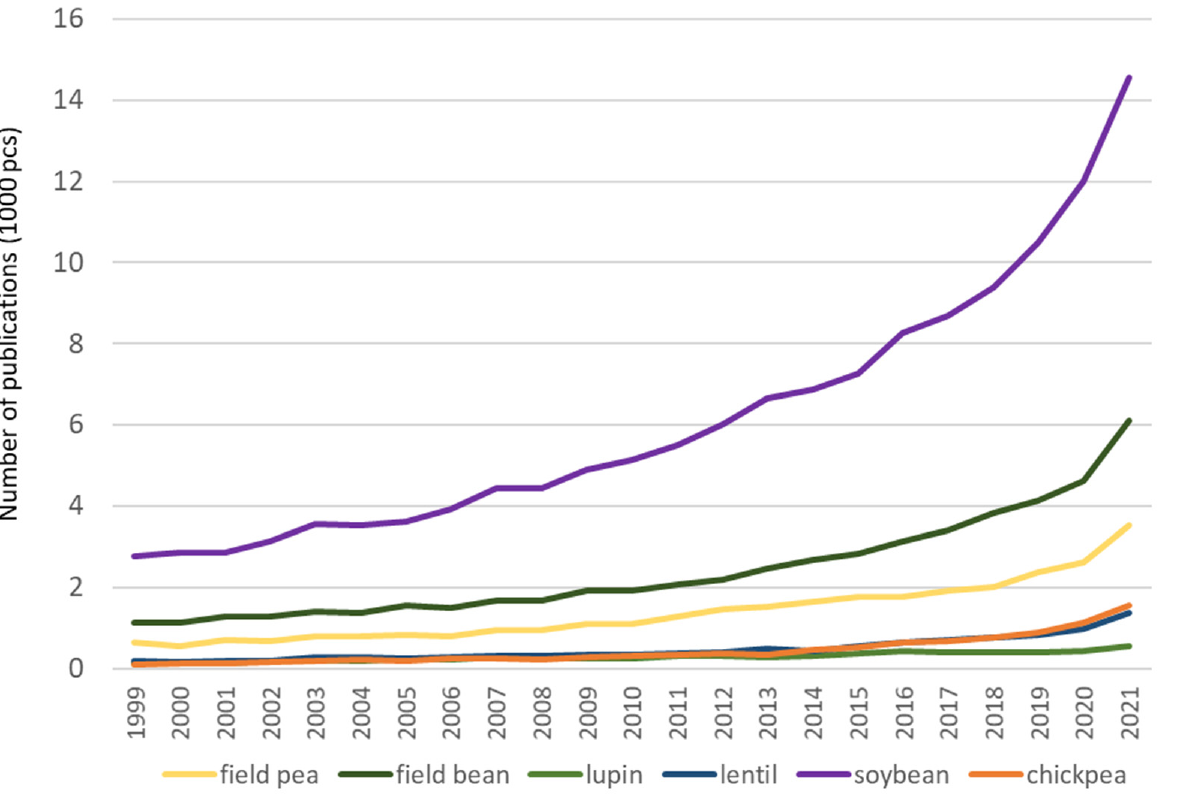
Figure 1. Number of scientific publications dealing with field peas, field bean, lupin, lentil, and soybean indexed by ScienceDirect [45] (accessed on 11 November 2021).